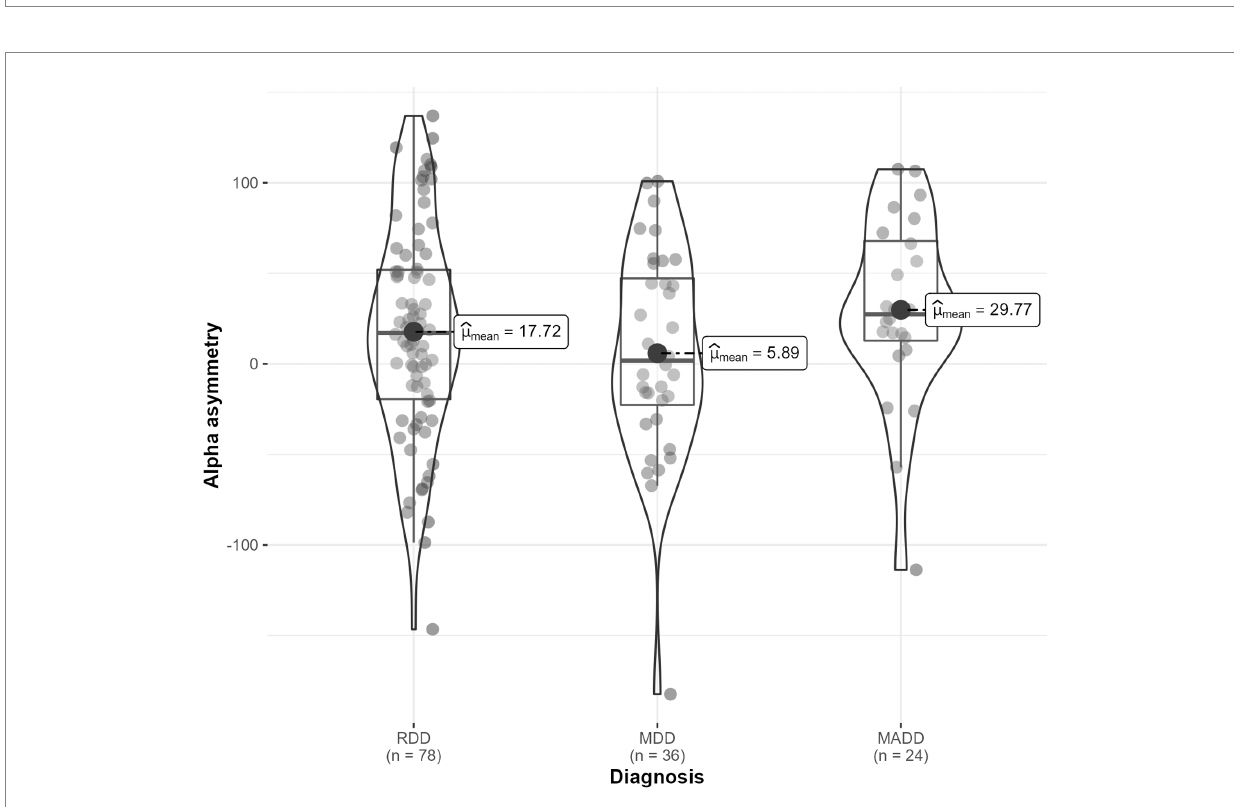
FIGURE 9 Frontal alpha asymmetry in three diagnostic categories (RDD, MDD,